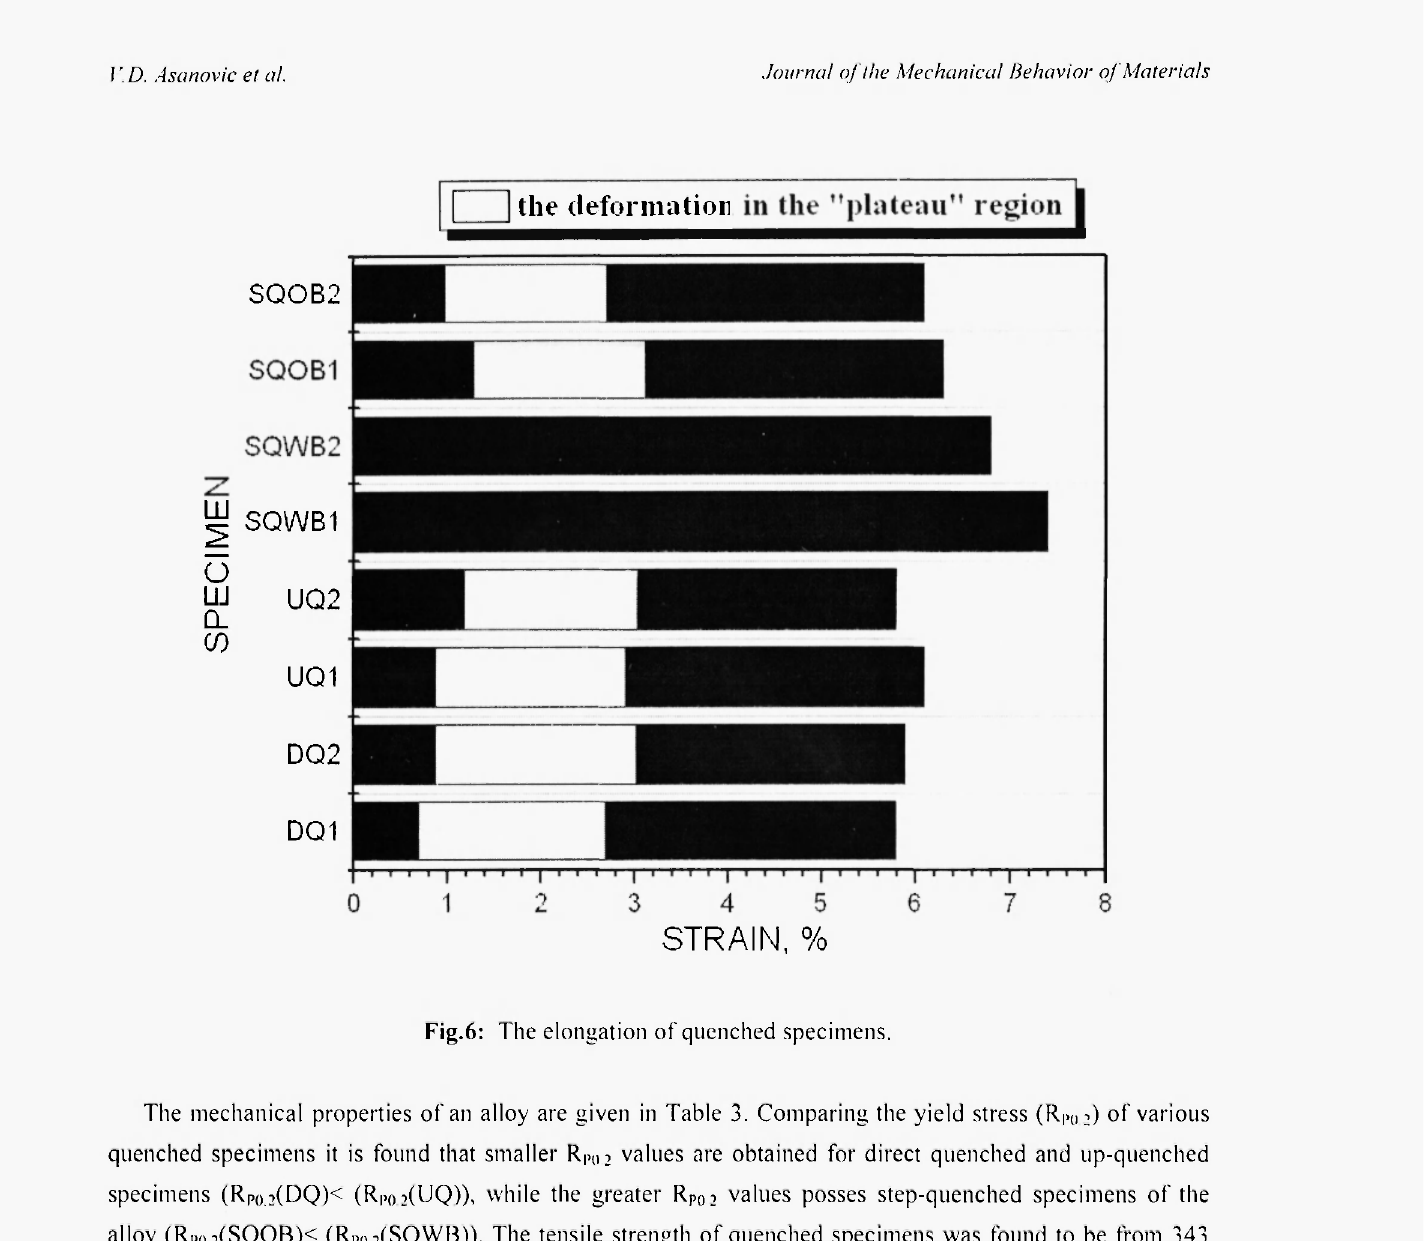
Fig.6: The elongation of quenched